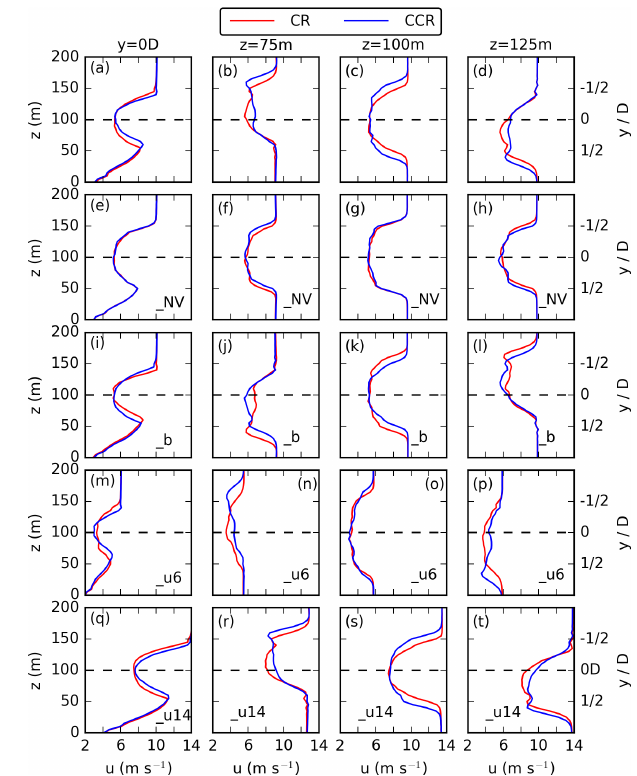
Figure 6. Vertical profiles (first column) and horizontal profiles at z = 75m (second column), z = 100m (third column), and z = 125m (fourth column) of the 30min averaged streamwise velocity at x = 7D downwind of the actuator for CR and CCR in (a–d) , CR_NV and CCR_NV in (e–h) , CR_b and CCR_b in (i–l) , CR_u6